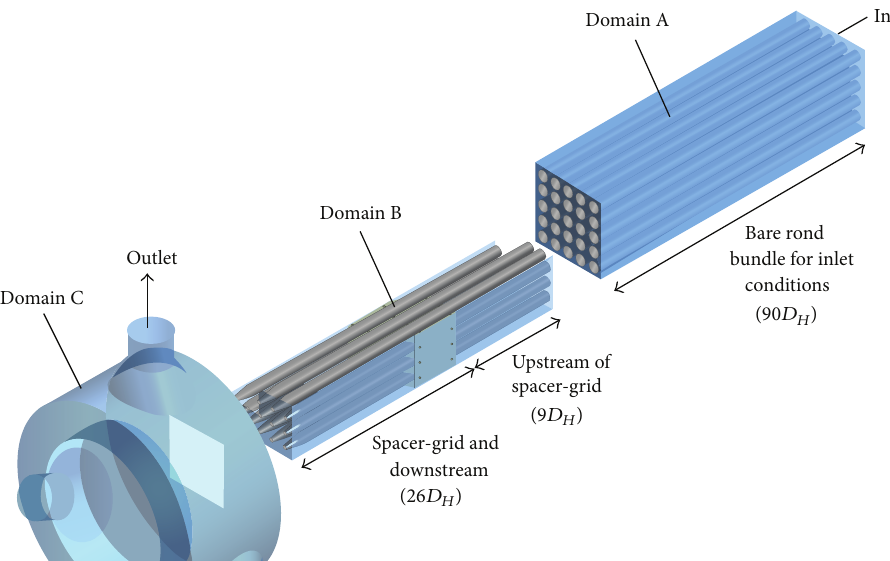
Figure 3: Domain decomposition of the test rig.